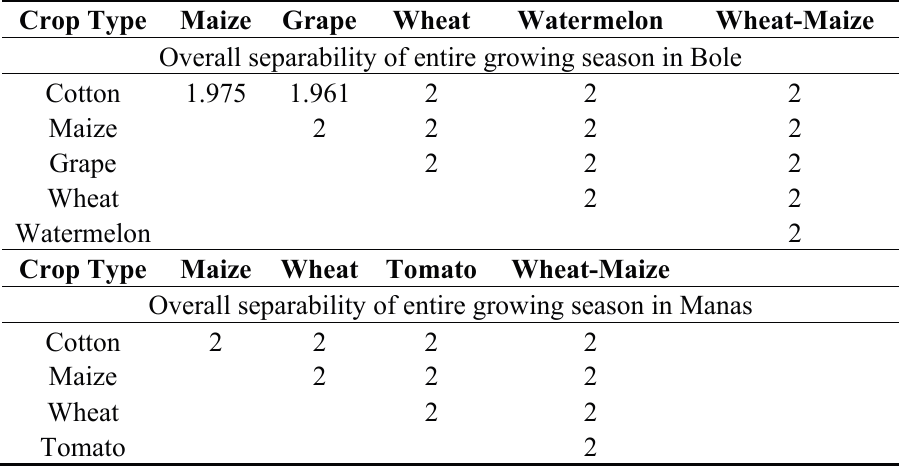
Table 5. Scene combination and their extension of JM distances for the entire time series. Scene Combination